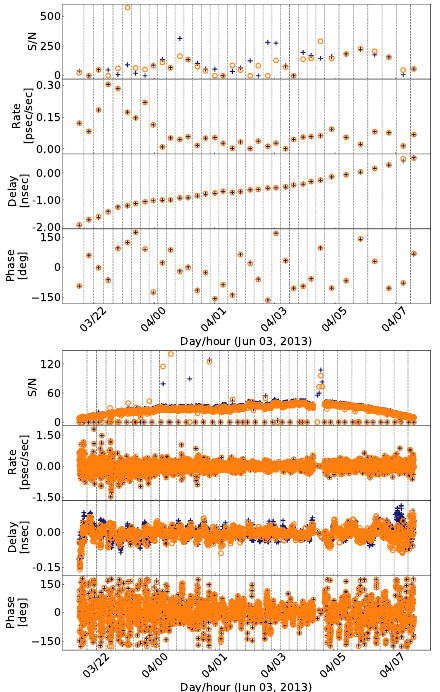
Figure 3. Example fringe solution diagnostics from rPICARD of M87 observed at 43GHz with the VLBA (project code BW0106). Dashed lines show scan boundaries. Crosses and circles correspond to RCP and LCP, respectively. Top : Gross per-scan solutions. Bottom : Residual atmospheric corrections on adaptive segmentation timescales after the solutions from the top panel have been applied to the